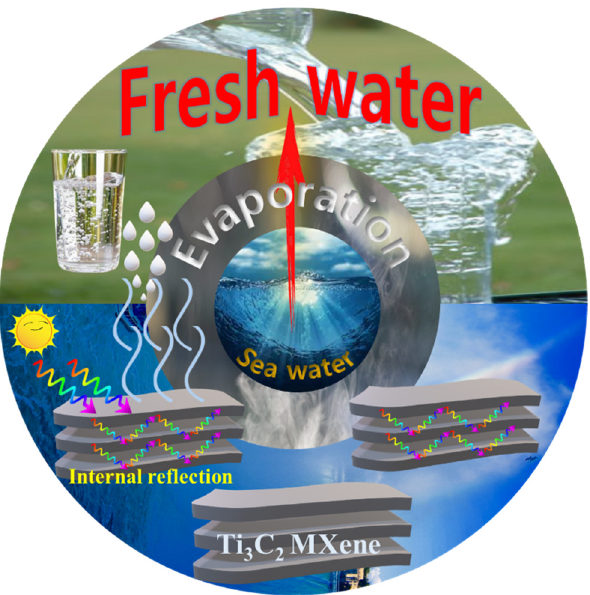
Figure 1. Schematic representation of seawater to freshwater generation by the 2D layer structured Ti 3 C 2 MXenes.